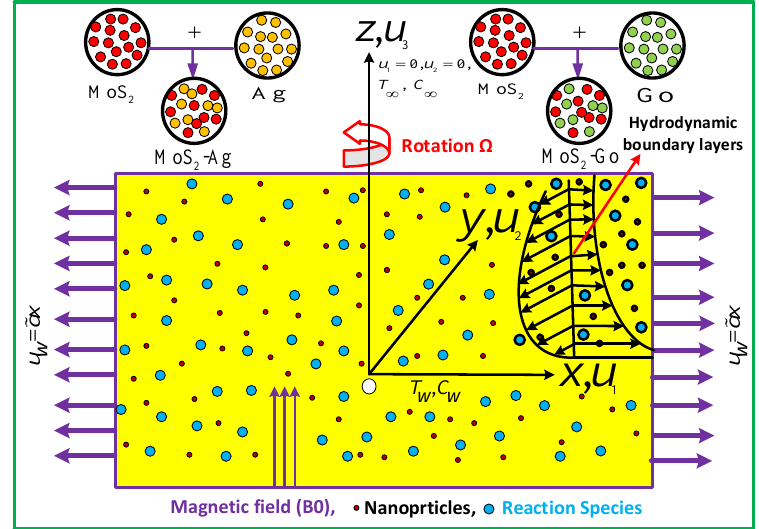
Figure 1. Schematic configuration with coordinate